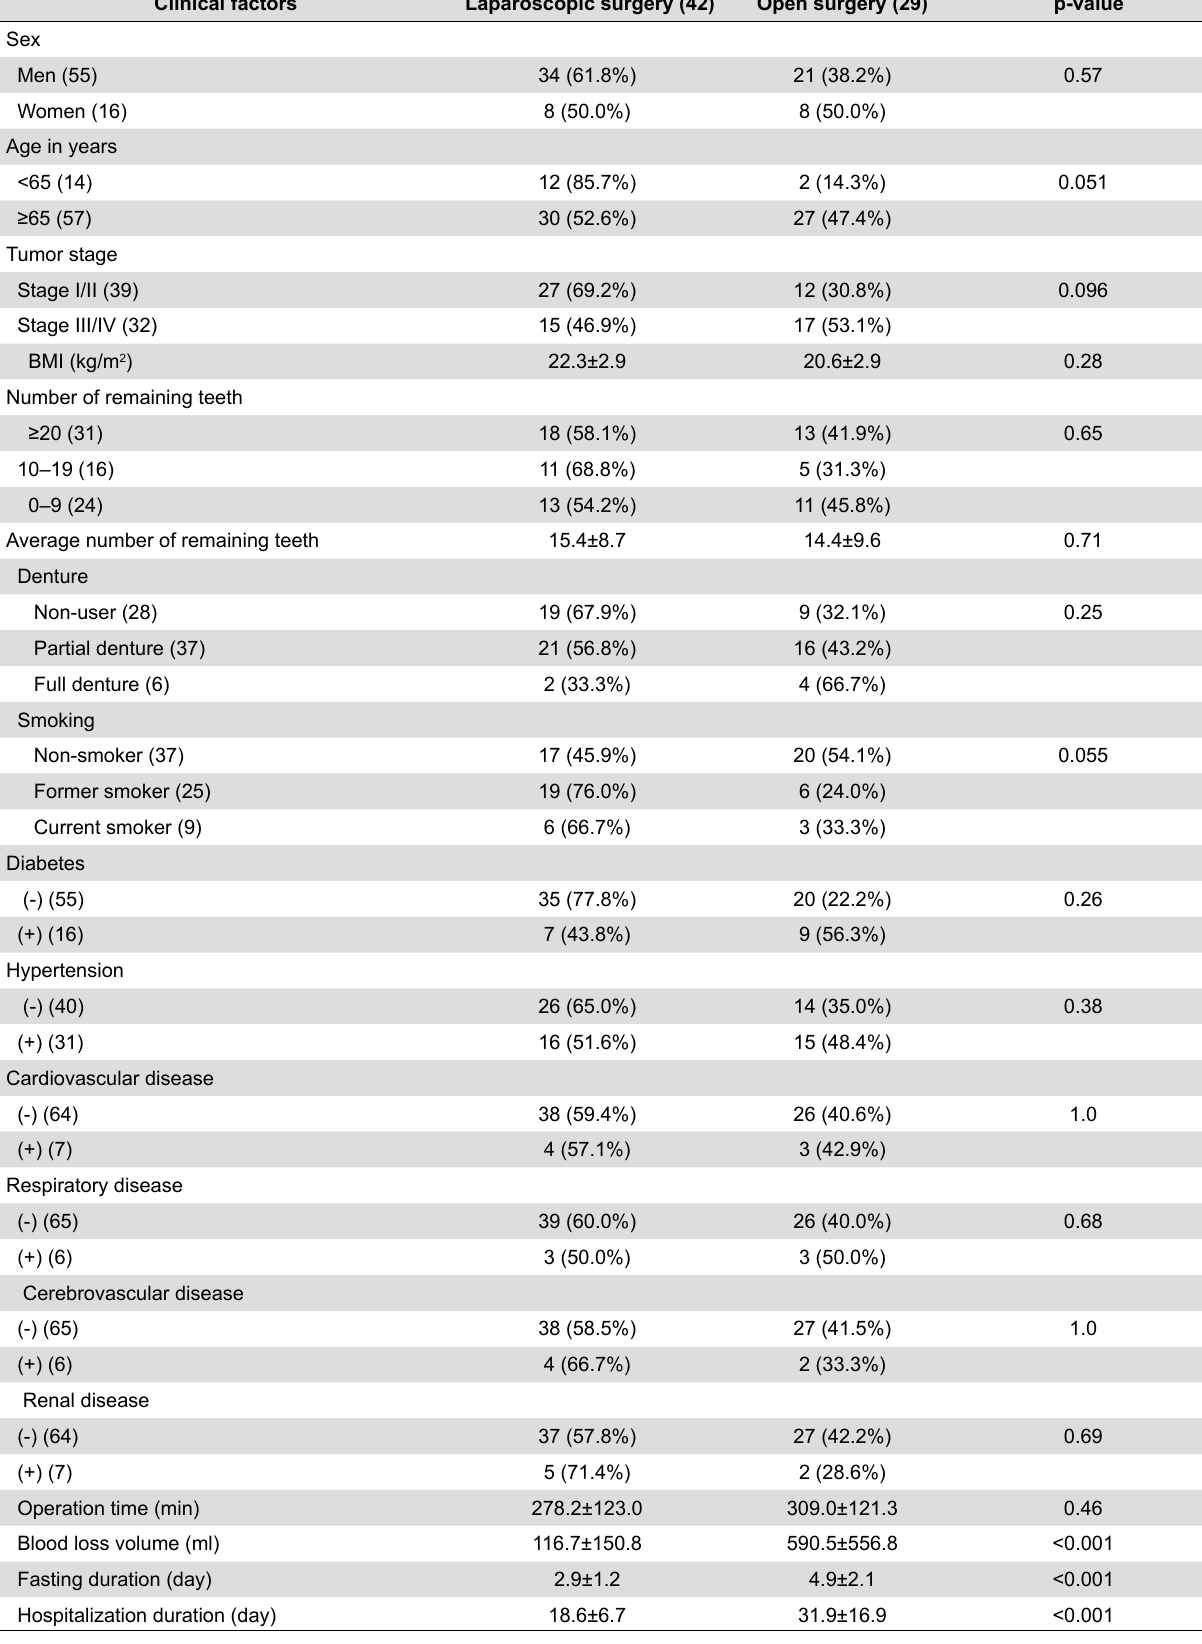
Table 1- Clinical factors of gastrointestinal cancer